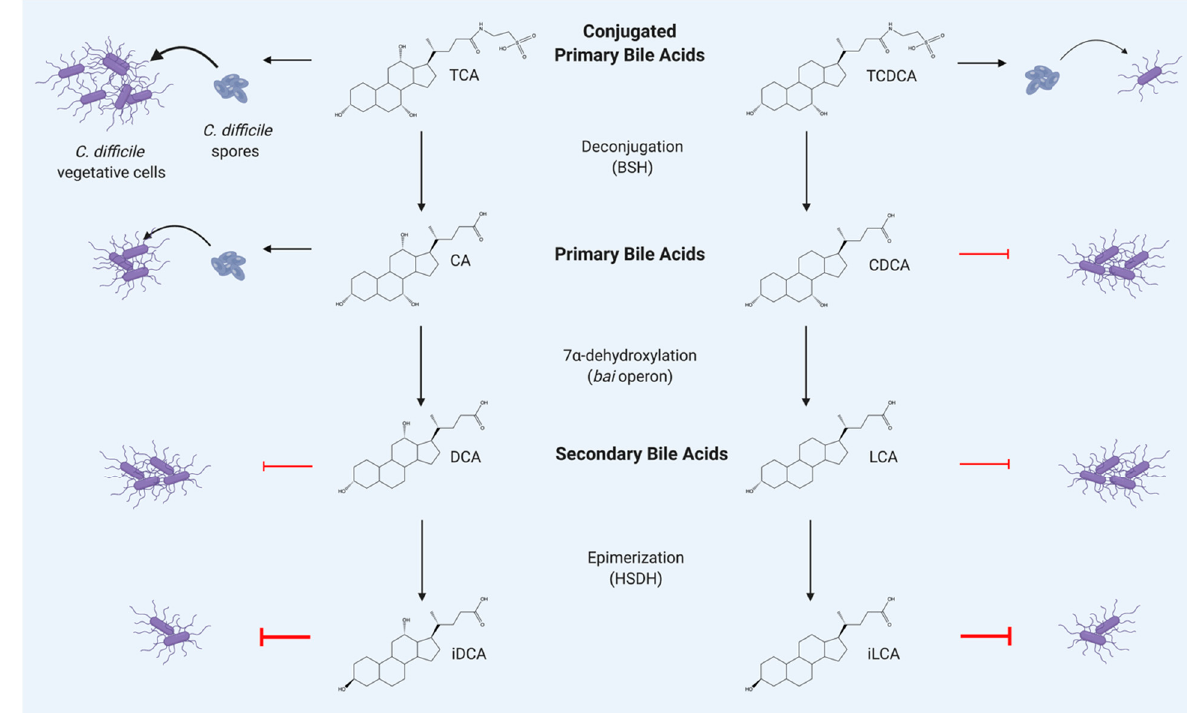
Figure 1. Selected transformations of bile acids carried out by gut bacteria and their effect on Clostridioides difficile. TCA is a strong germinant for C. difficile spores and TCDCA is a weak germinant. CA is a moderate germinant for C. difficile spores, and CDCA inhibits vegetative C. difficile. The secondary bile acids DCA and LCA inhibit vegetative C. difficile and iDCA and iLCA strongly inhibit C. difficile. Abb. BSH, bile salt hydrolase; bai, bile acid inducible; HSDH, hydroxysteroid dehydrogenase; TCA, taurocholate; TCDCA, taurochenodeoxycholate; CA, cholate; CDCA, chenodeoxycholate; DCA, deoxycholate; LCA, lithocholate; iDCA, isodeoxycholate; iLCA, isolithocholate. Created with BioRender.com .